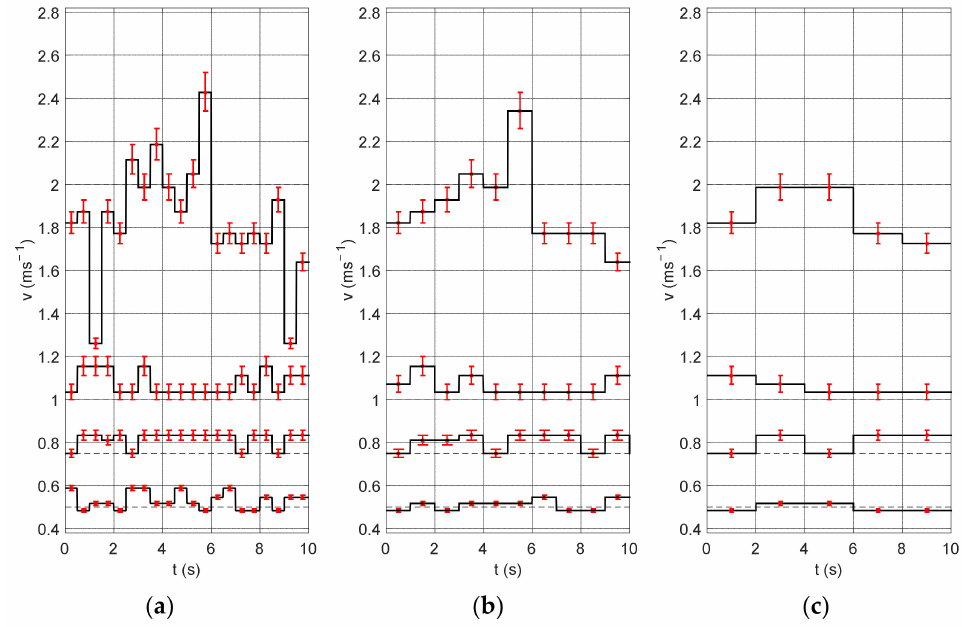
Figure 6. Cumulative results of the first experiment obtained for four velocity values: 0.5, 0.75, 1, and